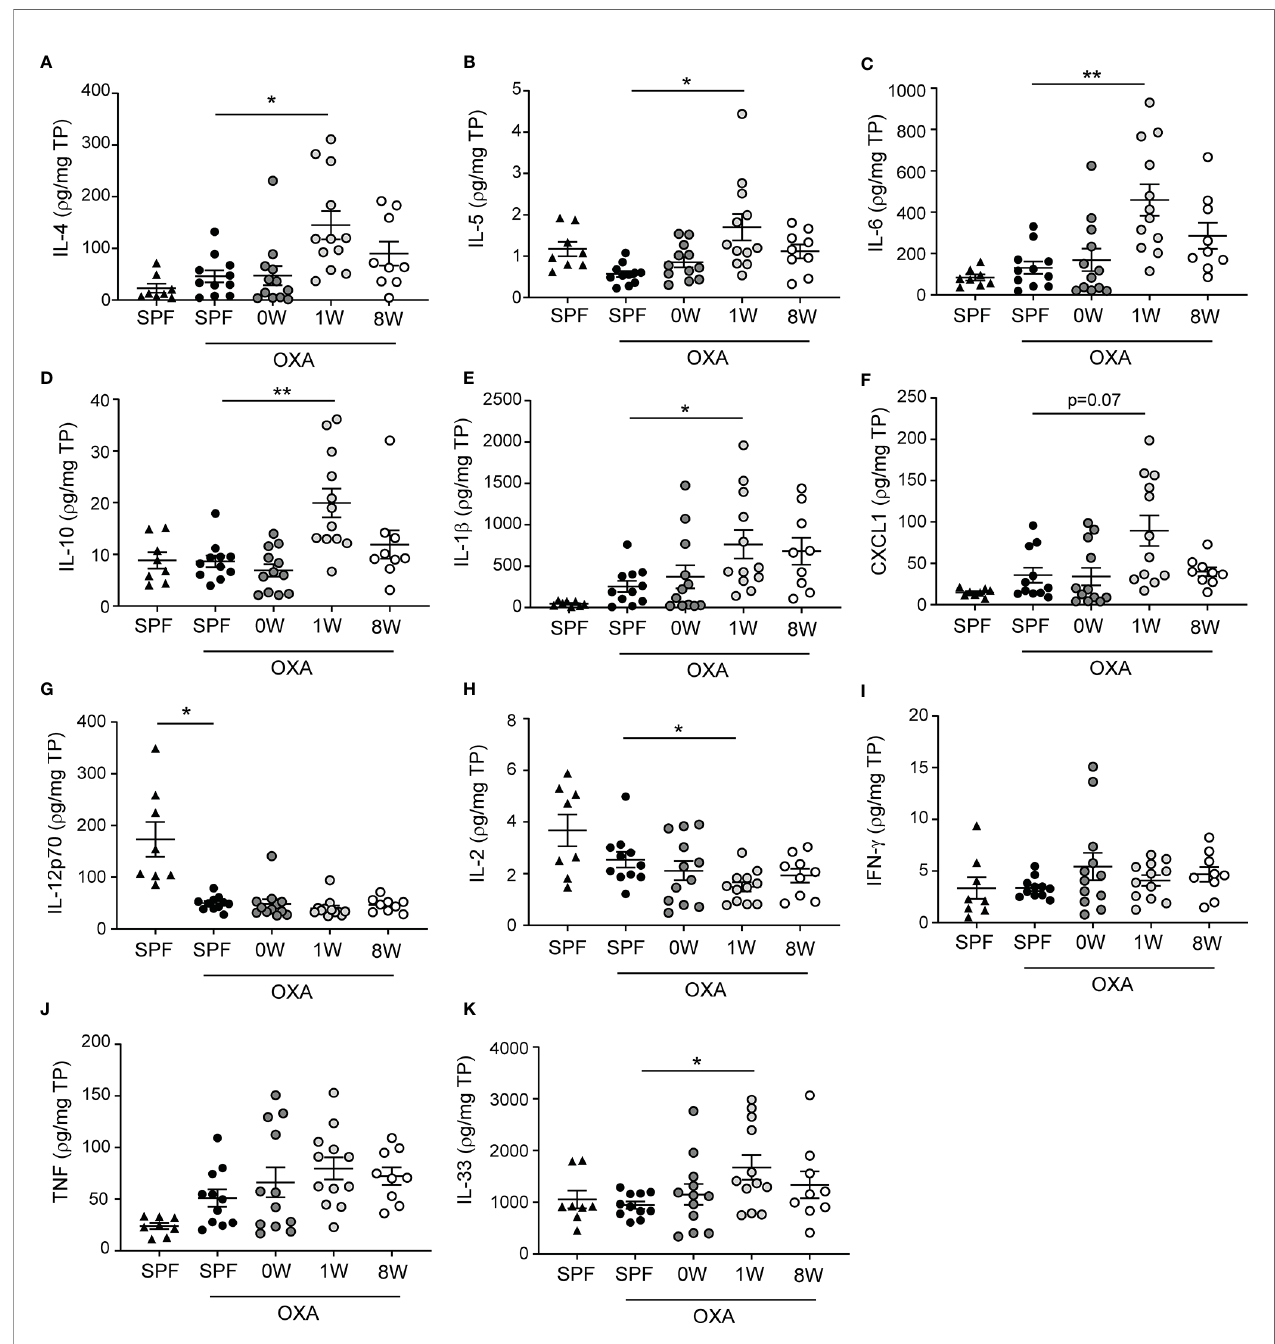
FIGURE 2 | Ear tissue cytokine levels were upregulated after a short-term delayed colonization. (A – K ) Cytokines were measured with two mesoscale multiplex kit in punch biopsies sampled from the in fl amed ear (SPF, n =11, 0W, n =12, 1W, n =12, 8W, n =9) and from untreated ears of SPF mice ( n =6) for comparison. The levels of each cytokine and chemokine were normalized to the total protein concentration per sample. Mean and SEM are shown for each cytokine. * indicates p < 0.05, ** indicate p < 0.01. All p -values below 0.1 are